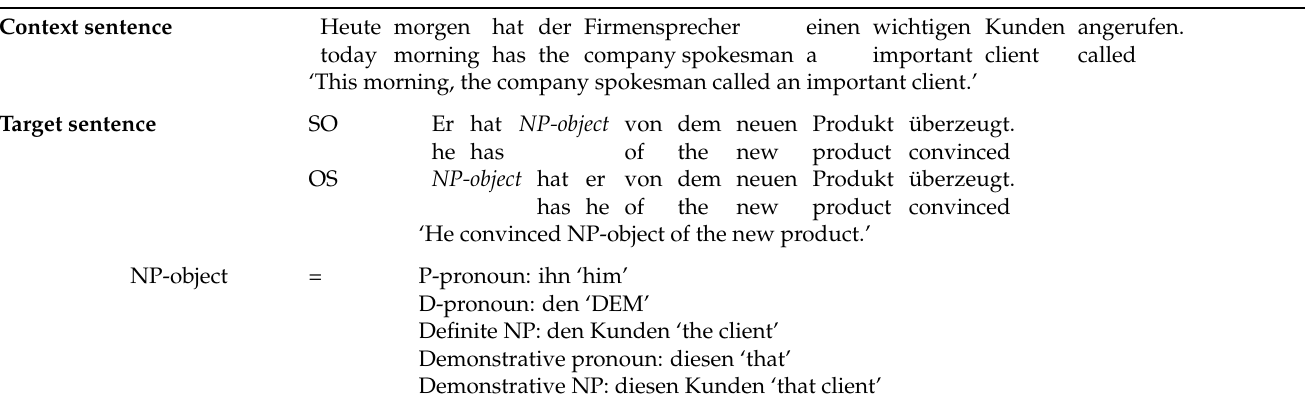
Table 1. Stimulus sentence from Experiment